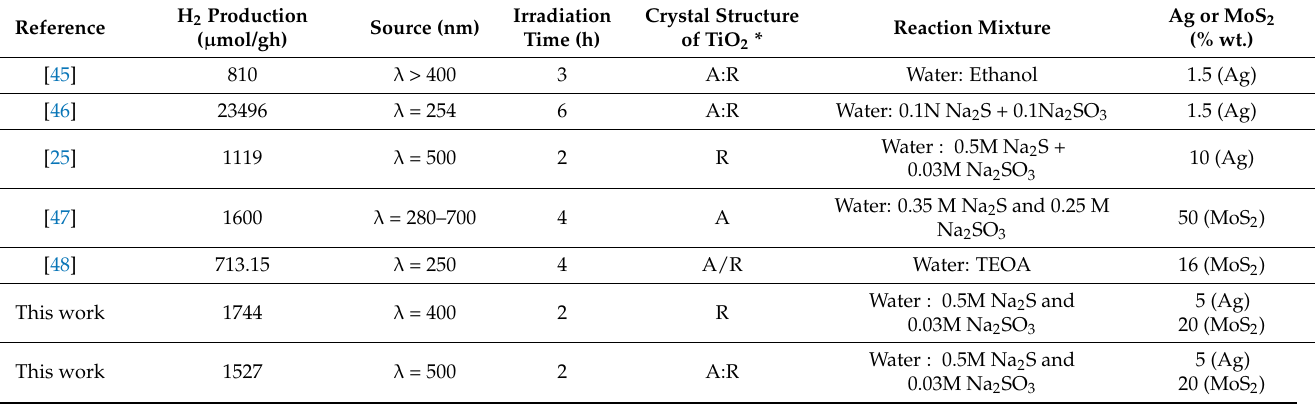
Table 6. Recent research on photocatalytic hydrogen production using catalysts containing AgNPs or MoS 2